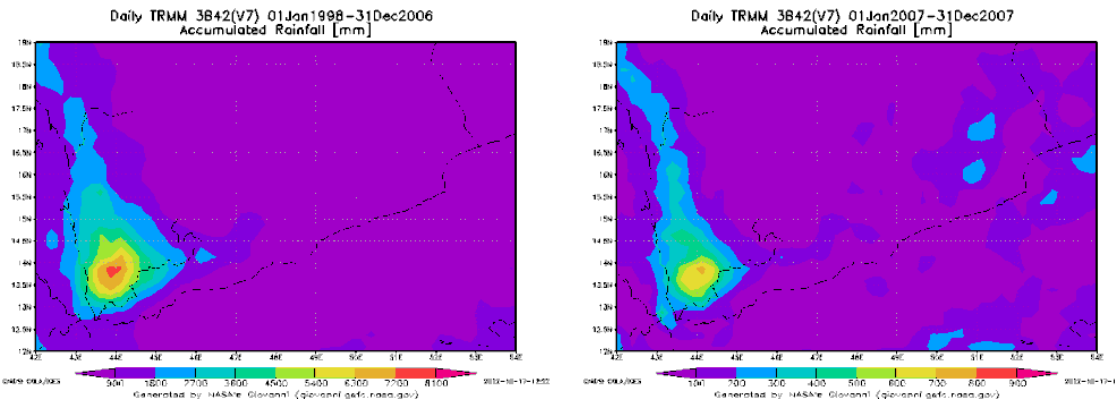
a) Normalized Difference